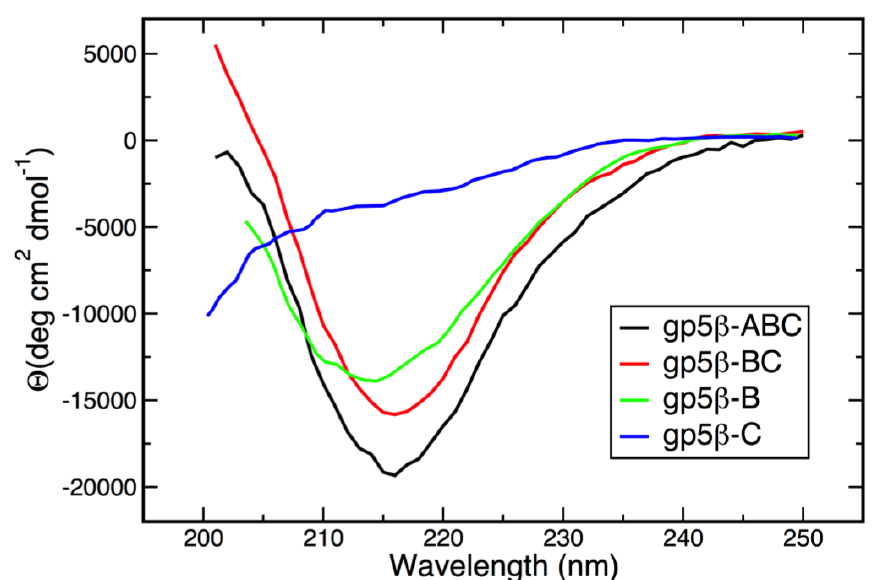
Figure 2. Circular dichroism spectra of gp5 β-helix fragments used in this study. CD spectra were recorded in 10 mM TrisHCl buffer, pH 8.0 at 25 °C.